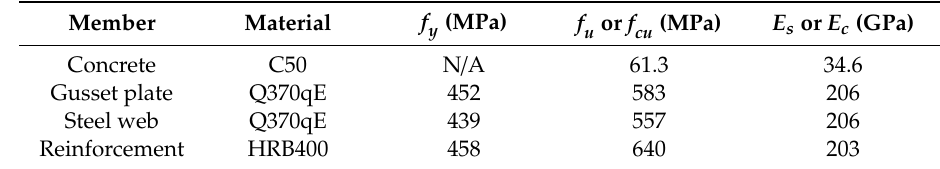
Figure 2. Schematic diagram of the specimen (unit: mm). Table 1. Material properties of the test specimen.